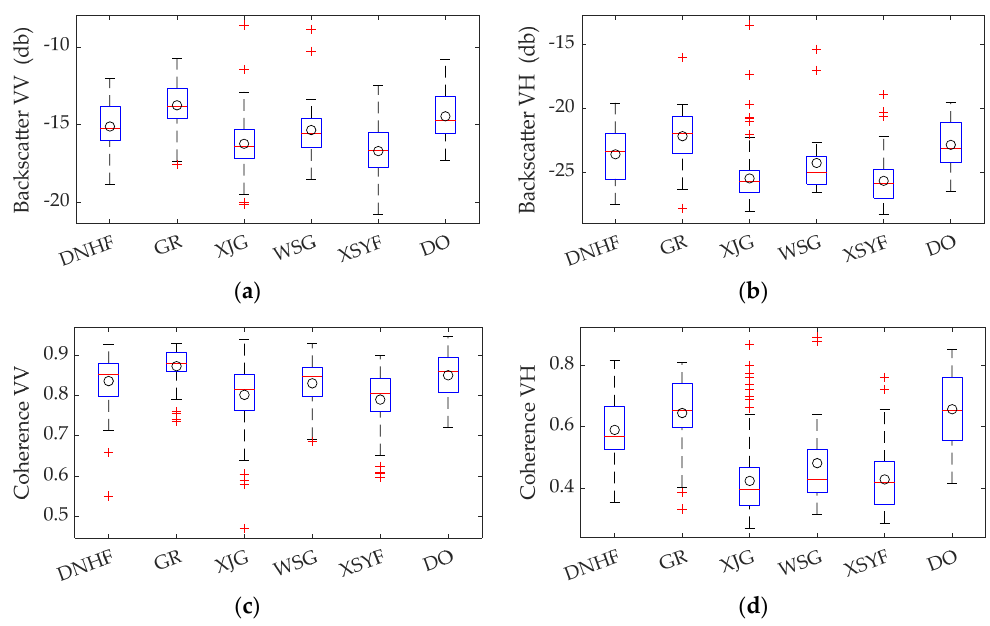
Figure 8. Box plots of variations of ( a ) Sentinel-1 backscatter coefficients at VV channel, ( b ) Sentinel-1 backscatter coefficients at VH channel, ( c ) Sentinel-1 coherence at VV channel and ( d ) Sentinel-1 coherence at VH channel (n = DNHF:43, GR:67, XJG:208, WSG:25, XSYF:73, DO:35). The mean value of each box is represented by the black circle. Table 2. Results of Kruskal–Wallis rank sum test.